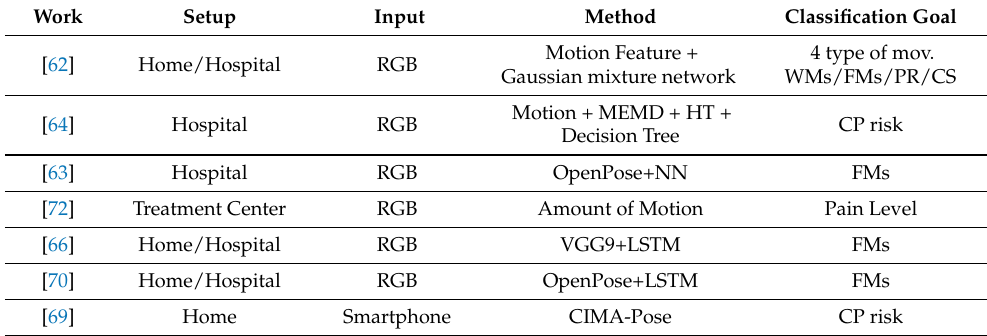
Table 3. Summarization of works dealing with movements assessment in